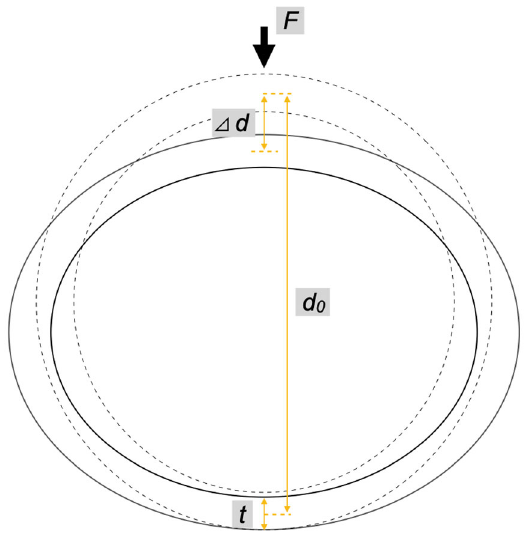
Figure 9. Schematic diagram of ring deflection of an RCP.